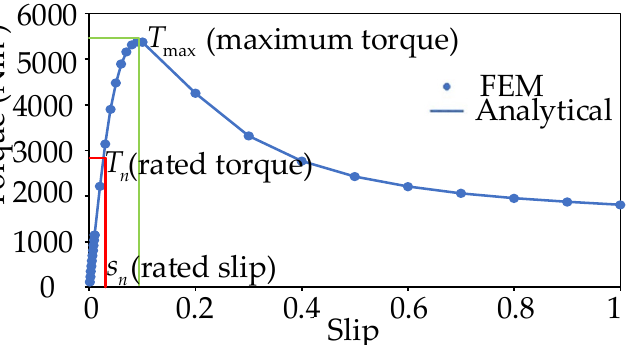
Figure 9. Comparison of the electromagnetic torque by 3D analytical calculation and the FEM.